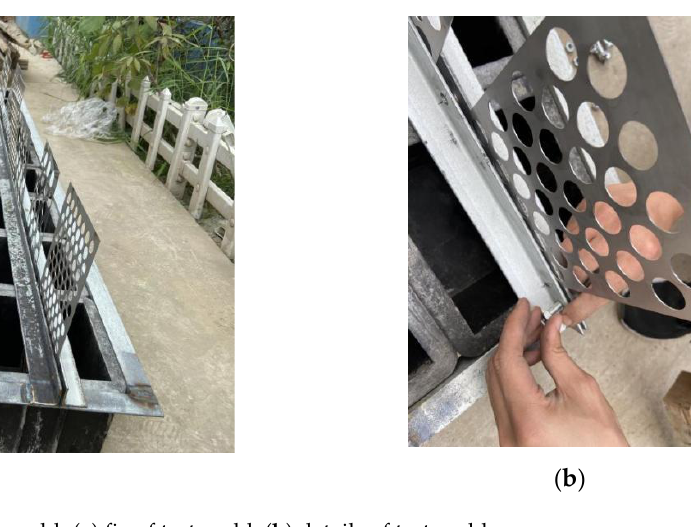
Figure 2. Test mold: ( a ) fix of test mold; ( b ) details of test mold.